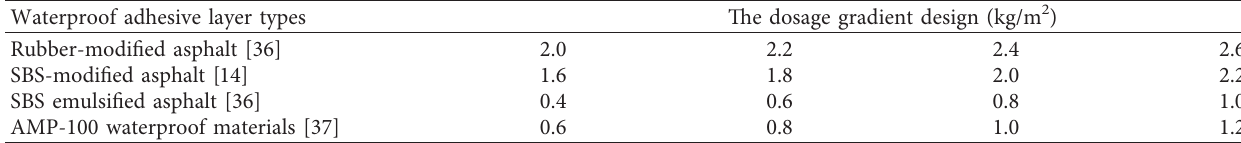
Table 4: Design of the waterproof adhesive layer for shear and pull-out